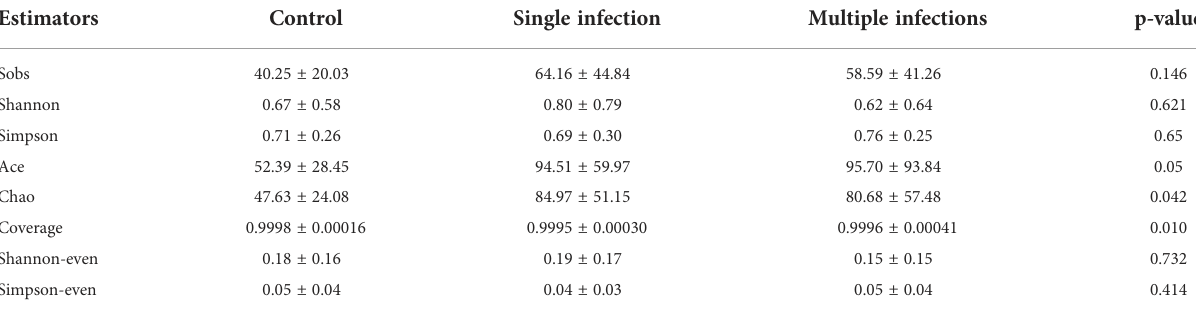
TABLE 4 The a -diversity of the vaginal microbial community compound at the species